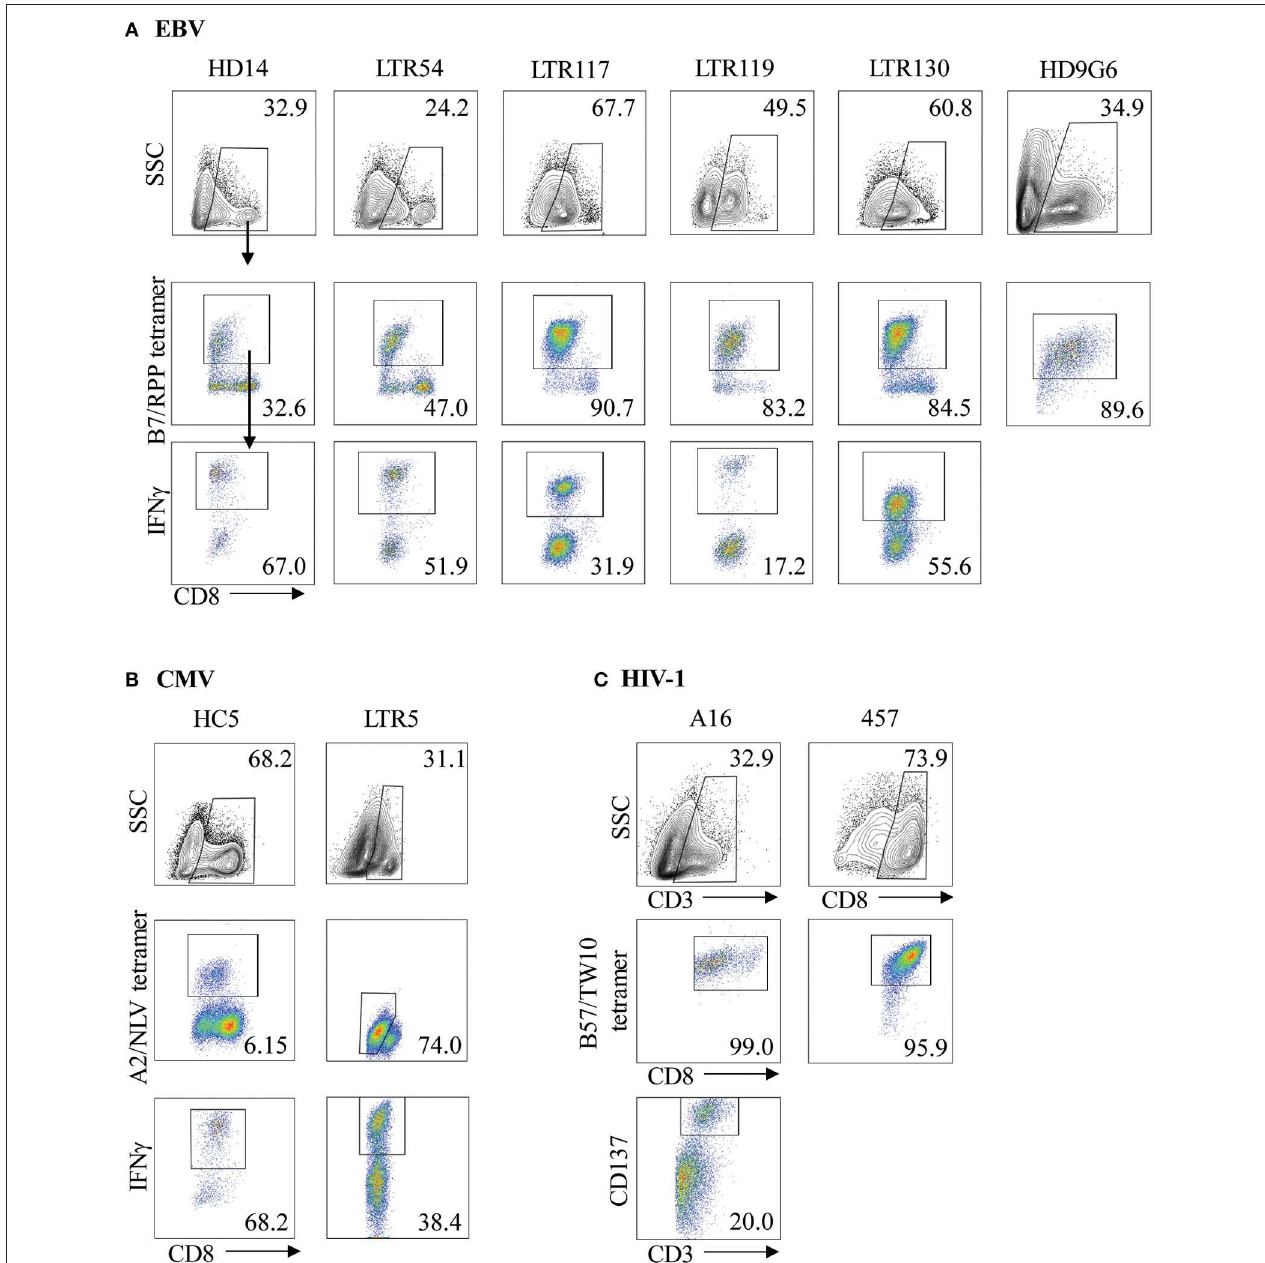
FIGURE 1 | Characterization of virus-specific CD8 + T cells. Virus-specific CD8 + T cell lines and clones for (A) EBV, (B) CMV, and (C) HIV-1 were examined for specificity following either re-stimulation with HLA-restricted APCs pulsed with cognate viral peptide or bulk PBMC sorting, using both anti-CD8 and specific tetramer. The functionality of virus-specific CD8 + tetramer + T cells was assessed either using IFN γ production for T cell lines or via the CD137 activation marker for HIV-1T cell clones. Cells were gated on FSC vs. SSC, single cells, CD8 + , CD8 + tetramer + , CD8 + IFN γ + cells. Representative plots are shown.